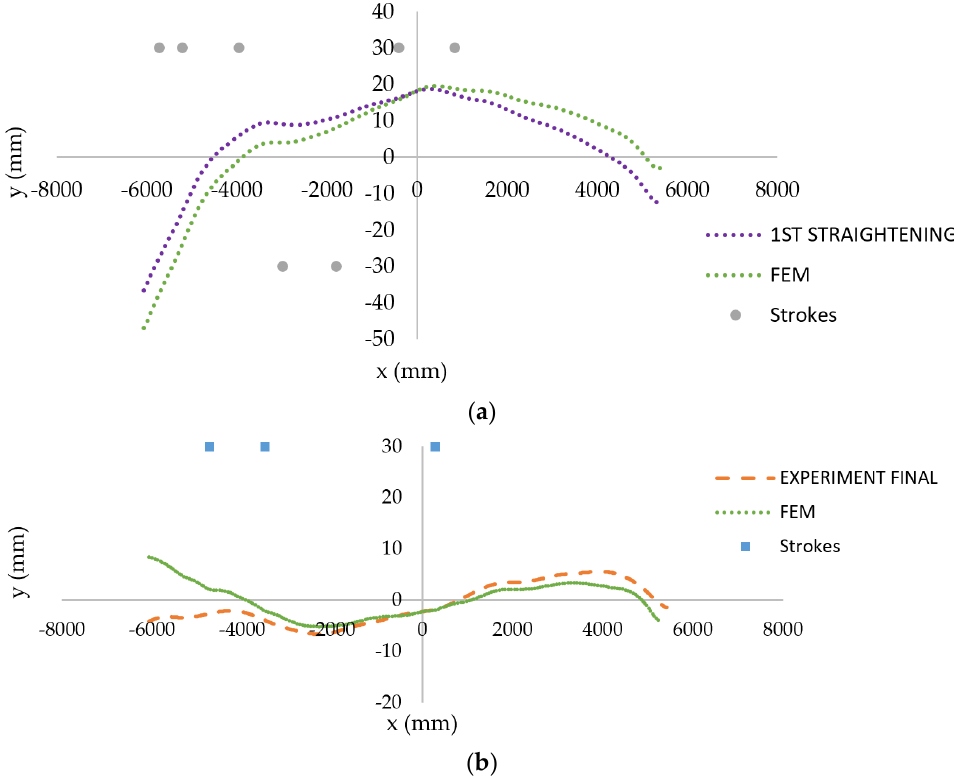
Figure 20. Comparison of experimental and predicted shapes of the exemplary “snake-like” billet: after first straightening ( a ) and after second straightening ( b ).